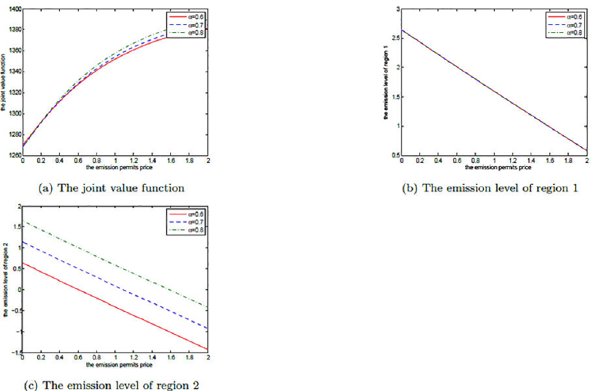
Fig 3. The effects of α on the cooperative